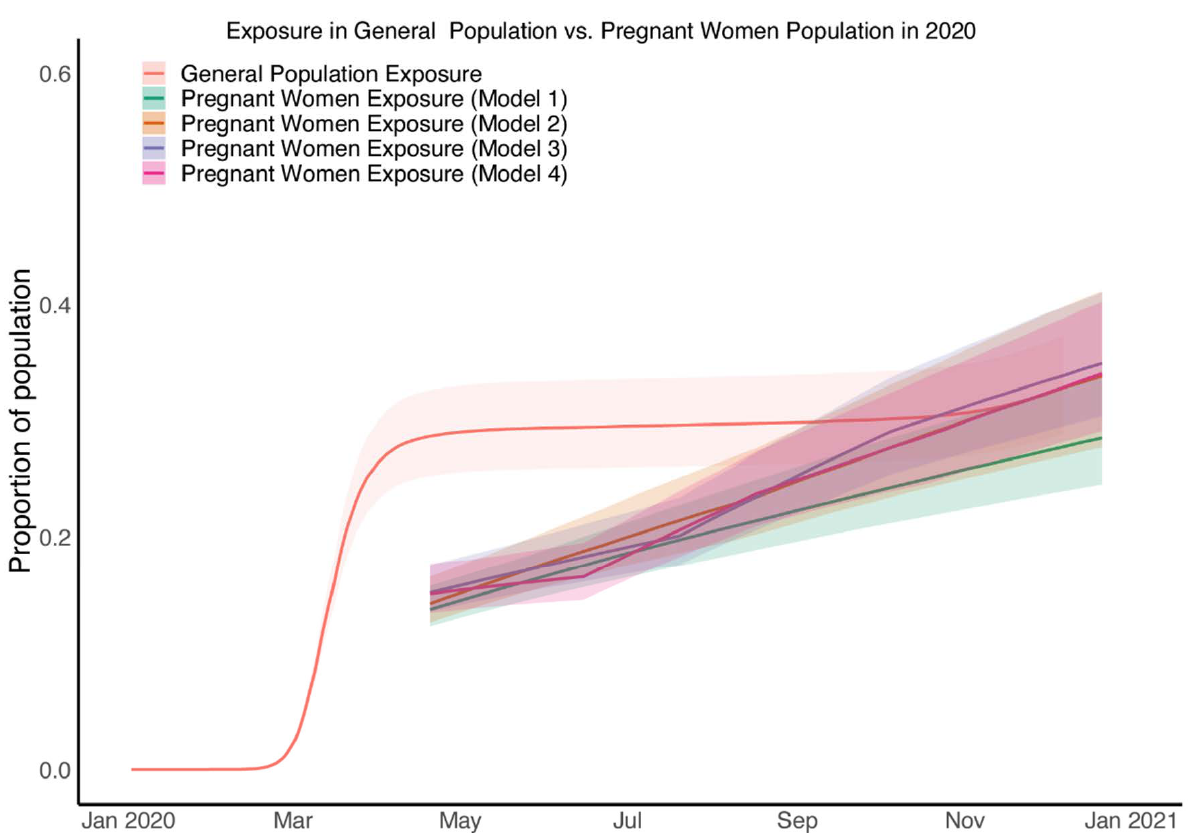
Figure 4. Comparisons of estimates of exposure in patients who were giving birth from four models and general population. The red line shows the median estimates of exposure from general population while the shaded areas correspond to the 95% credible interval; the green, yellow, green, blue and pink line shows the median estimates of exposure from Model 1, Model 2, Model 3 and Model 4 for patients who were giving birth, respectively, while the deep and shadow shaded areas correspond to the 50% credible intervals.